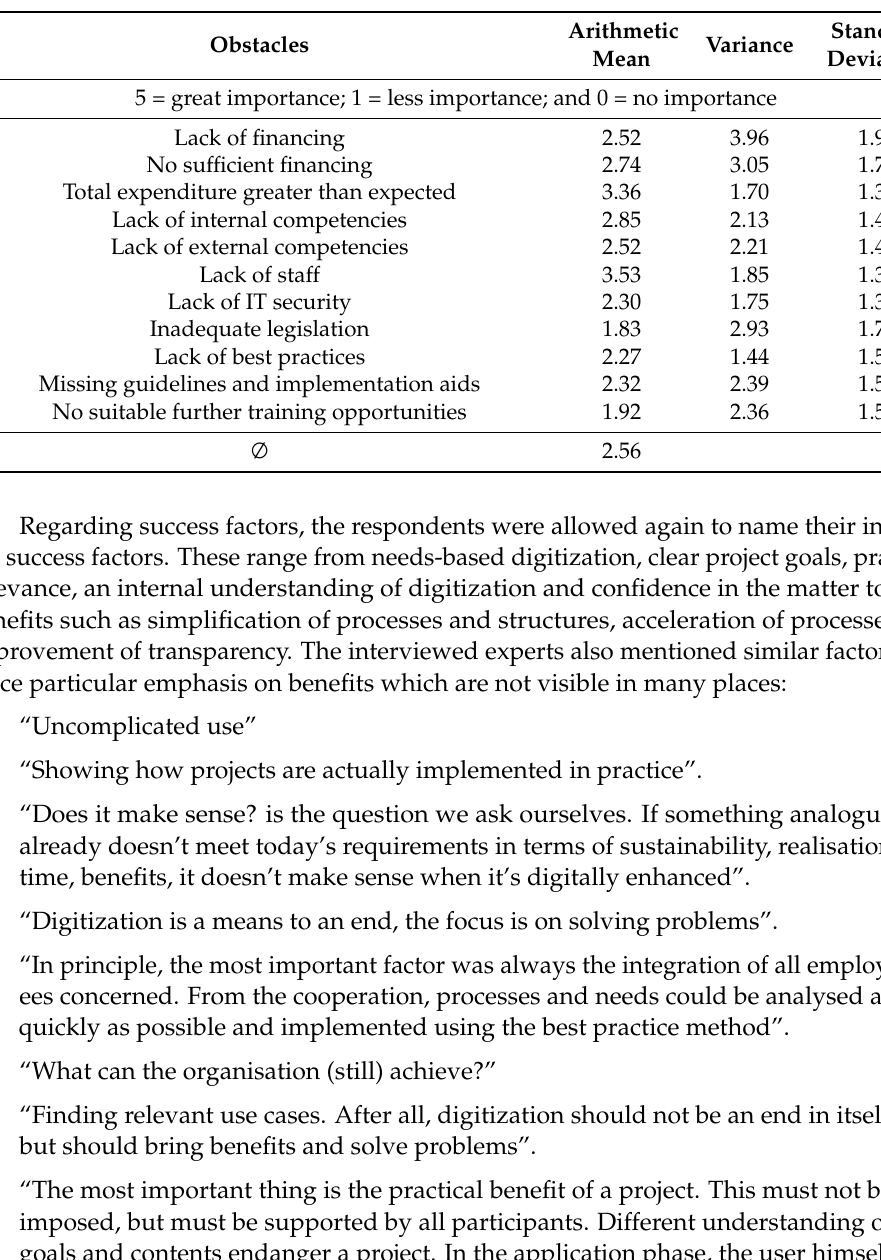
Table 3. Freely expressed obstacles in digitization projects ( n =